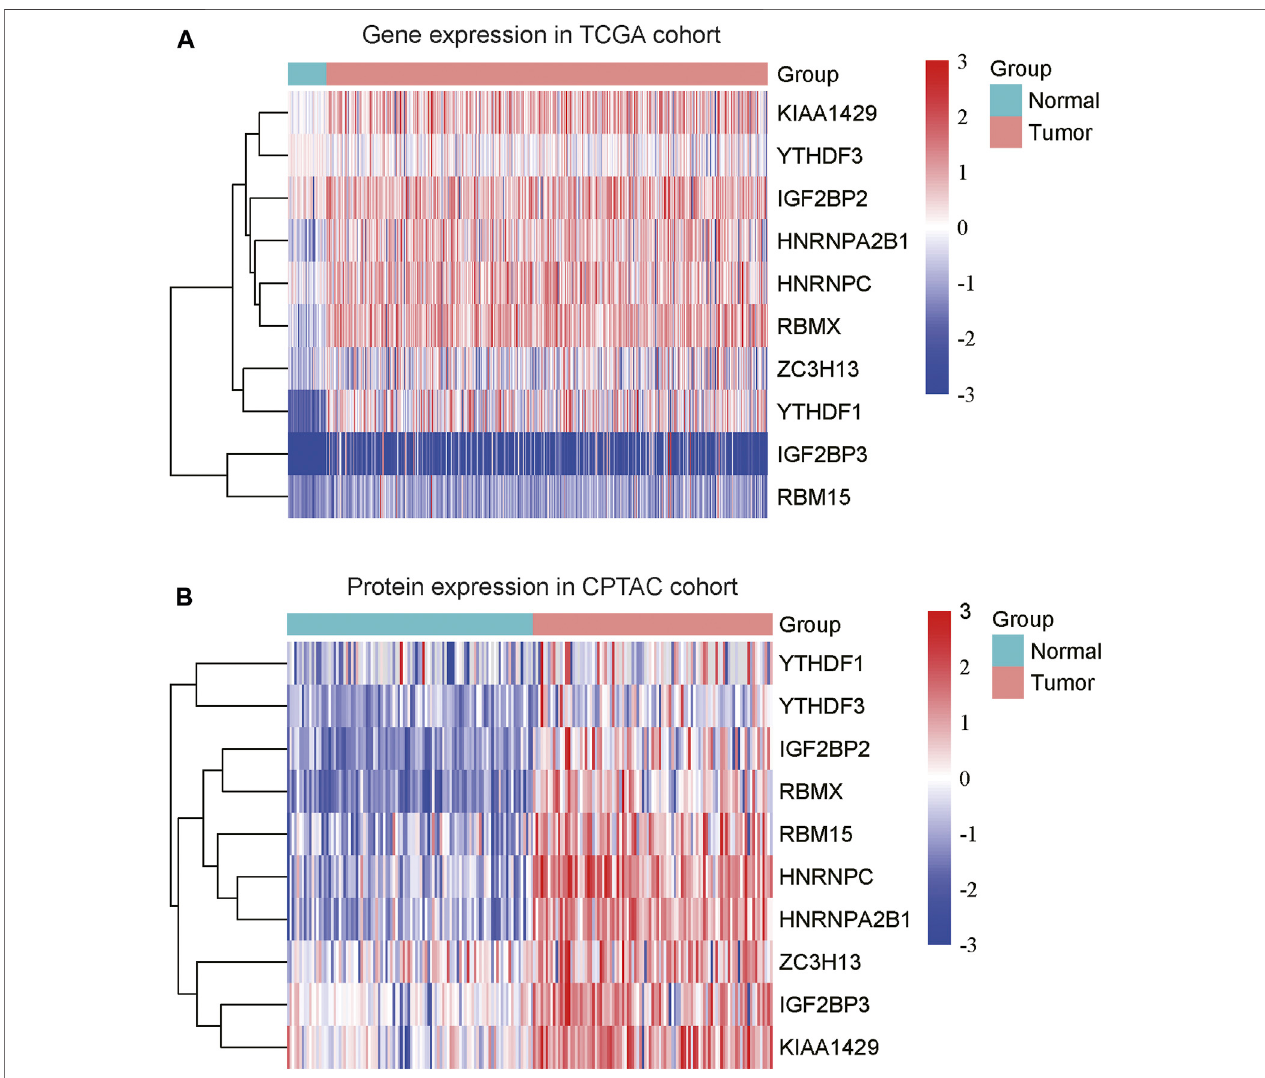
FIGURE1| Thedifferentially expressed m6AregulatorsinCOAD. Thetenm6AregulatorswereupregulatedinCOADat bothmRNA (A) andprotein (B) levels. The expression levels were scaled at − 3 to 3.